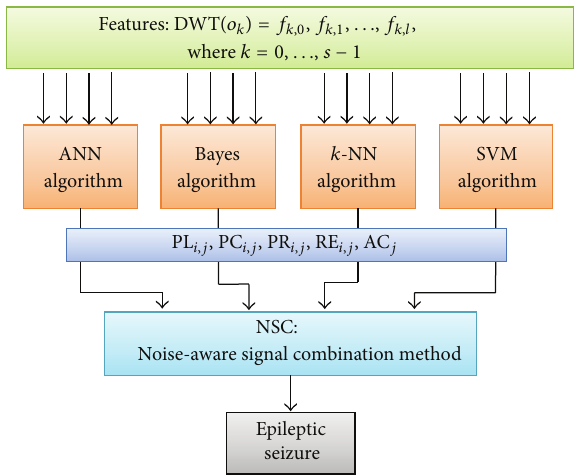
Figure 3: Proposed ensemble system.